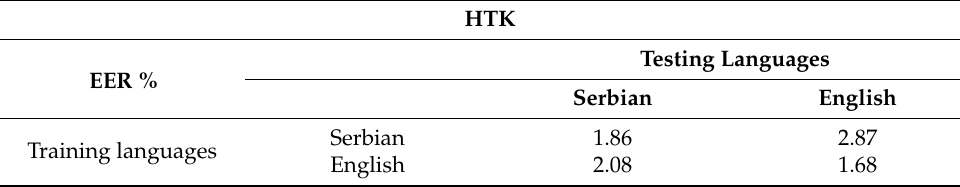
Table 5. The best HTK performance, as measured by EER, compared to the languages